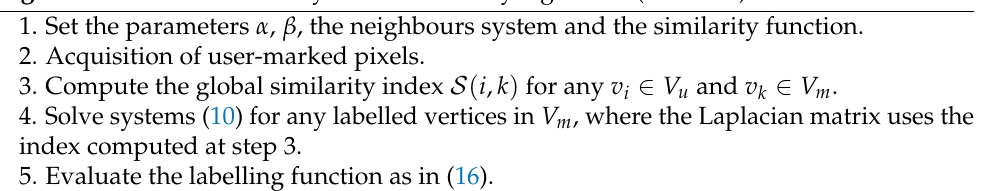
Algorithm 1 Random walk by colour similarity algorithm (RaWaCS)